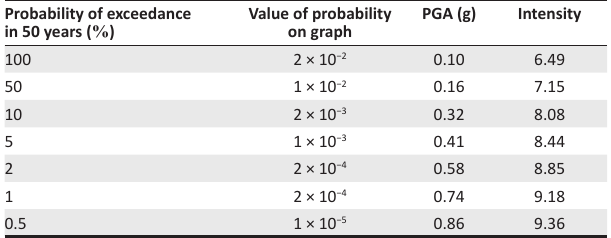
Value of probability on